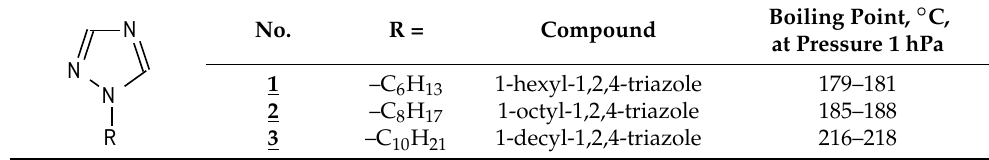
Table 1. Properties of 1-alkyl-triazoles.